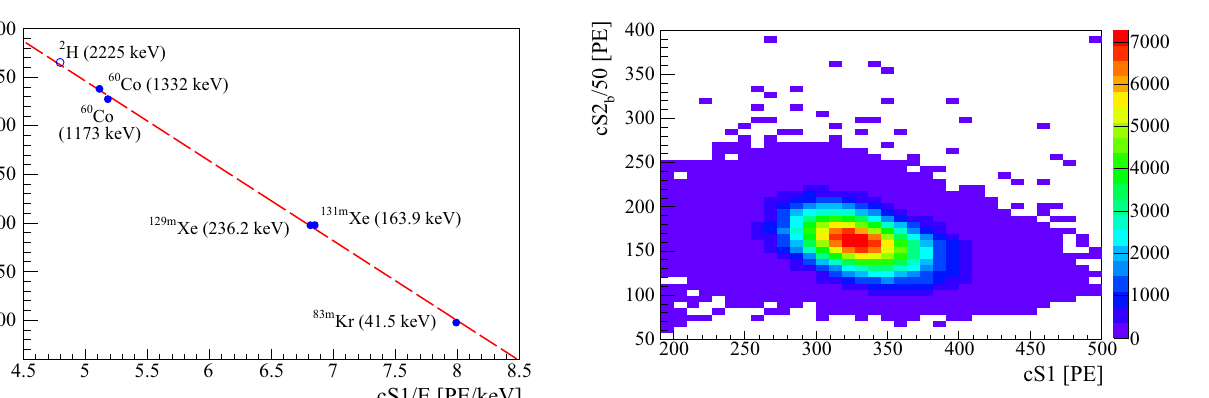
Fig. 23 The scintillation (cS1) and ionization signals (cS2) for various mono-energeticpeaks,correctedforpositiondependenteffectsandnor- malized to the line energy, show the expected anti-correlated behavior. The fit to the data allows the extraction of the primary (in PE/ γ ) and secondary scintillation gain (in PE/e − ). The signal at 2.2MeV is due to de-excitation γ rays from neutron capture on hydrogen ( 1 H ( n ,γ) 2 H).